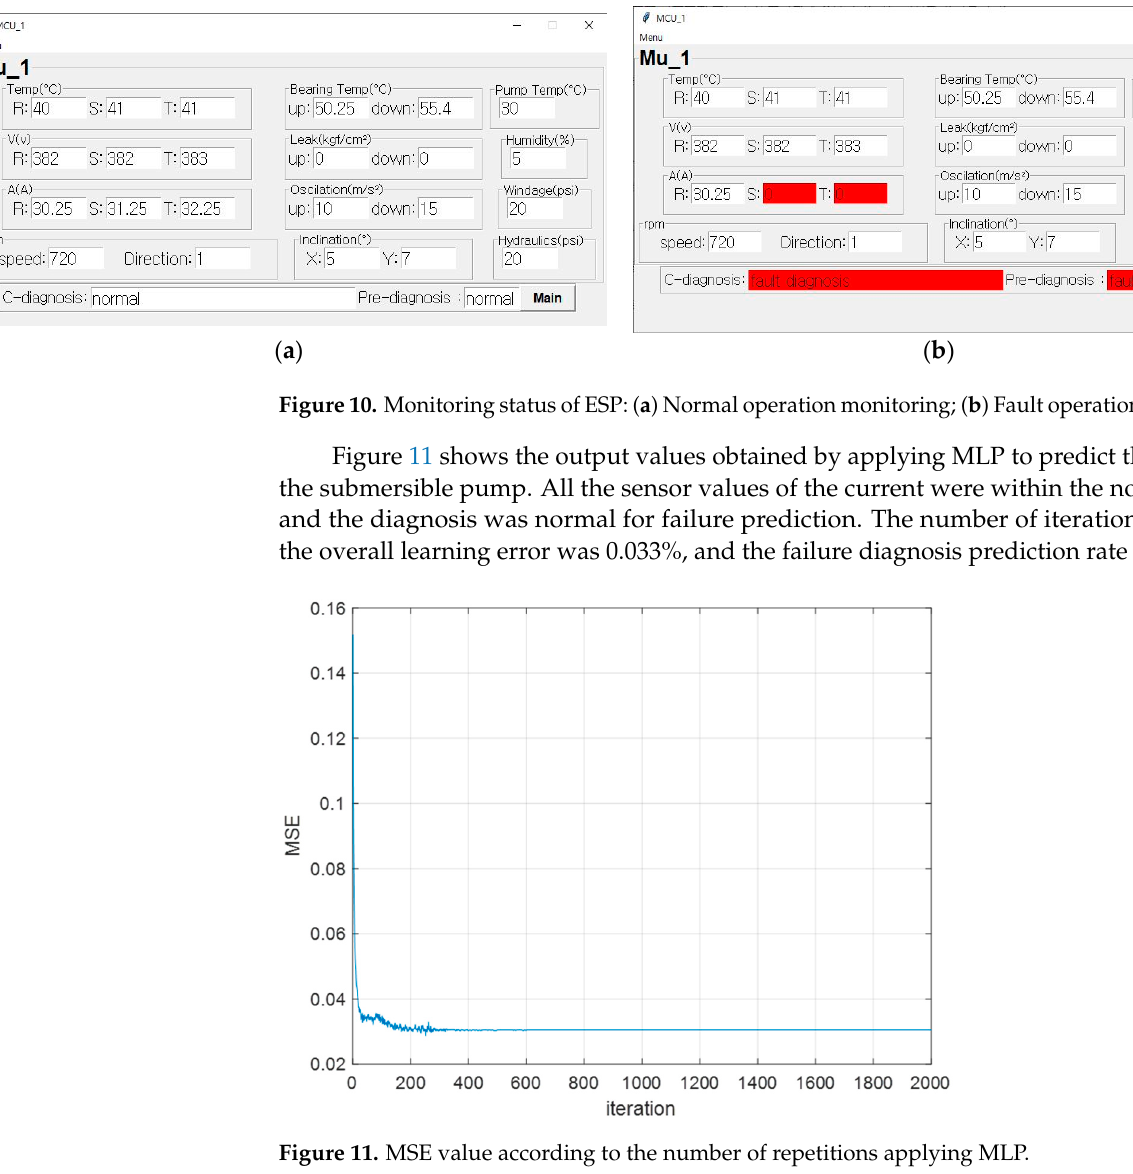
Figure 11. MSE value according to the number of repetitions applying MLP.